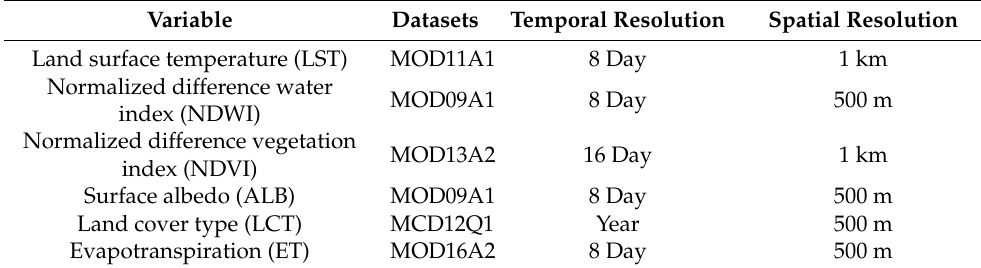
Table 1. MODIS products and related variables used in this study. Variable Datasets Temporal Resolution Spatial